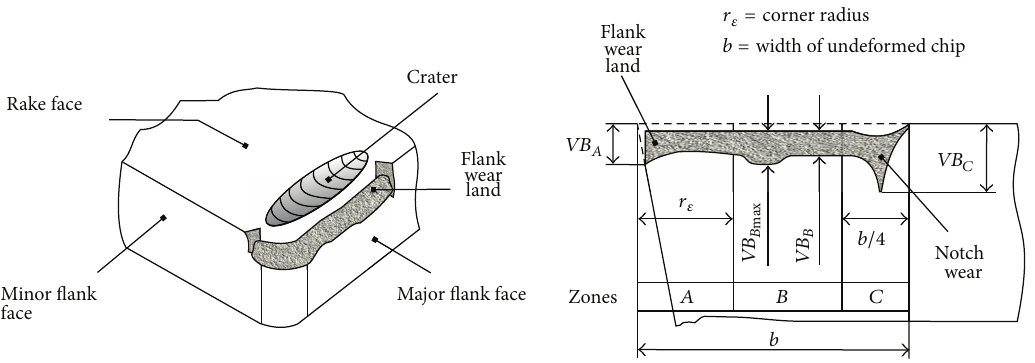
Figure 1: Form of tool